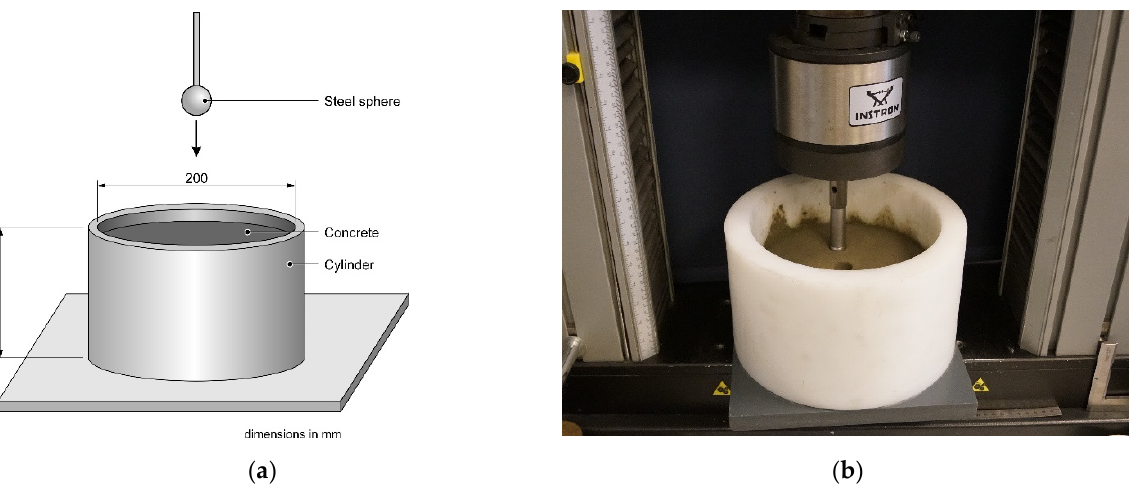
Figure 4. Sketch of the experimental set-up of a penetration test ( a ) and recording of the penetration of the sphere ( b ).